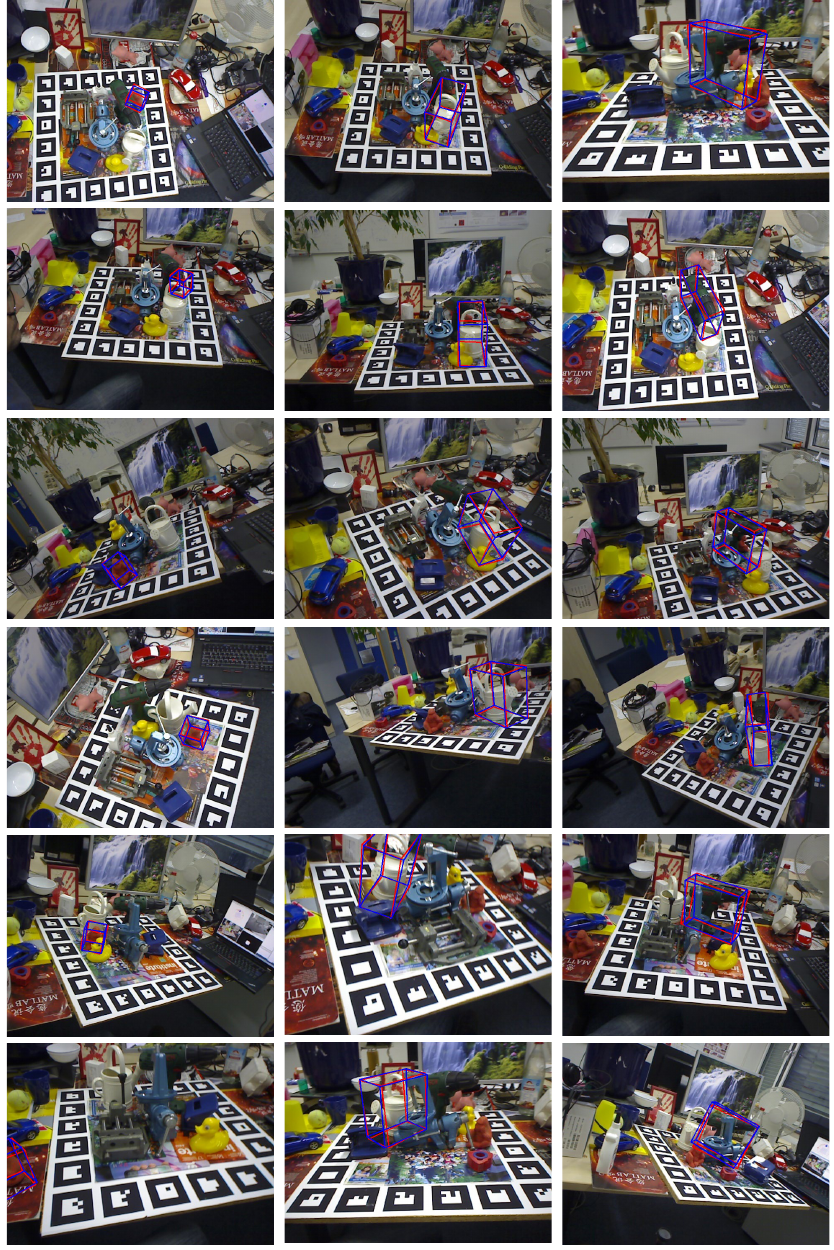
Figure 9. Estimated 6D pose on an Occluded LineMOD dataset [6]. The red and blue bounding boxes denote the ground truth and results estimated by DeepHMap++, respectively. The left column is the results of Ape sequence. The middle column is the results from Can sequence. The right column is the results from Driller